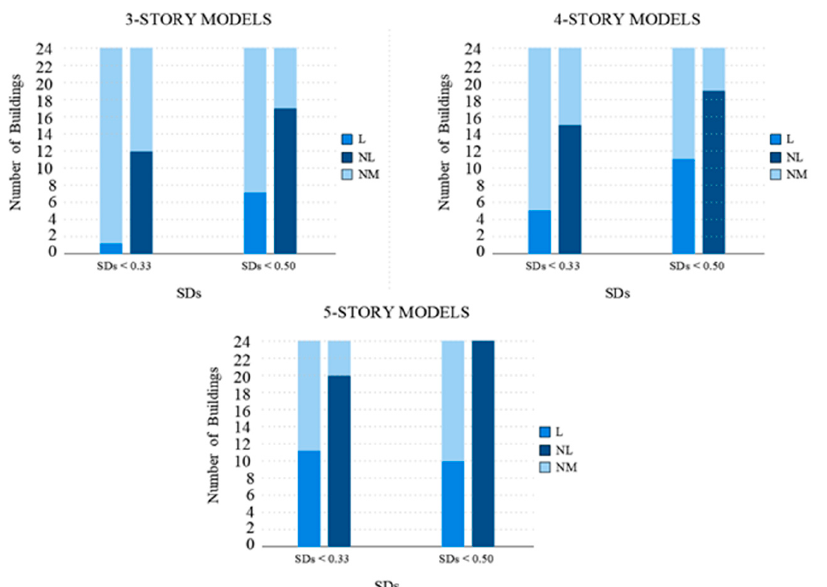
Figure 15. Distribution of buildings with sufficient performance according to the S DS /storey number.